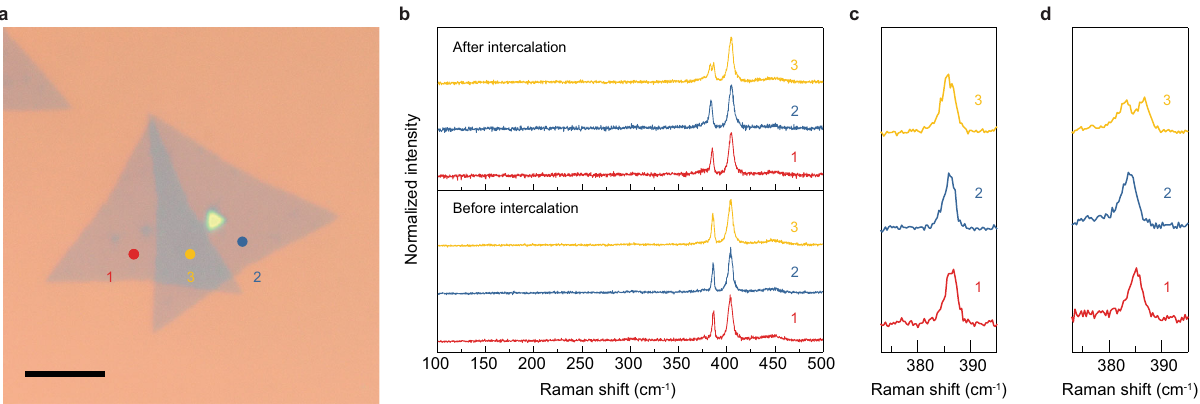
Fig. 2 The intermediate state in lithium intercalated twisted bilayer MoS 2 . a Optical microscope image of a twisted bilayer MoS 2 (scale bar 10 μ m). b Raman spectra of the positions 1, 2, and 3 in a before intercalation. c Raman spectra of the same positions after intercalation. d Zoom-in image of the E 2g and A 1g peaks